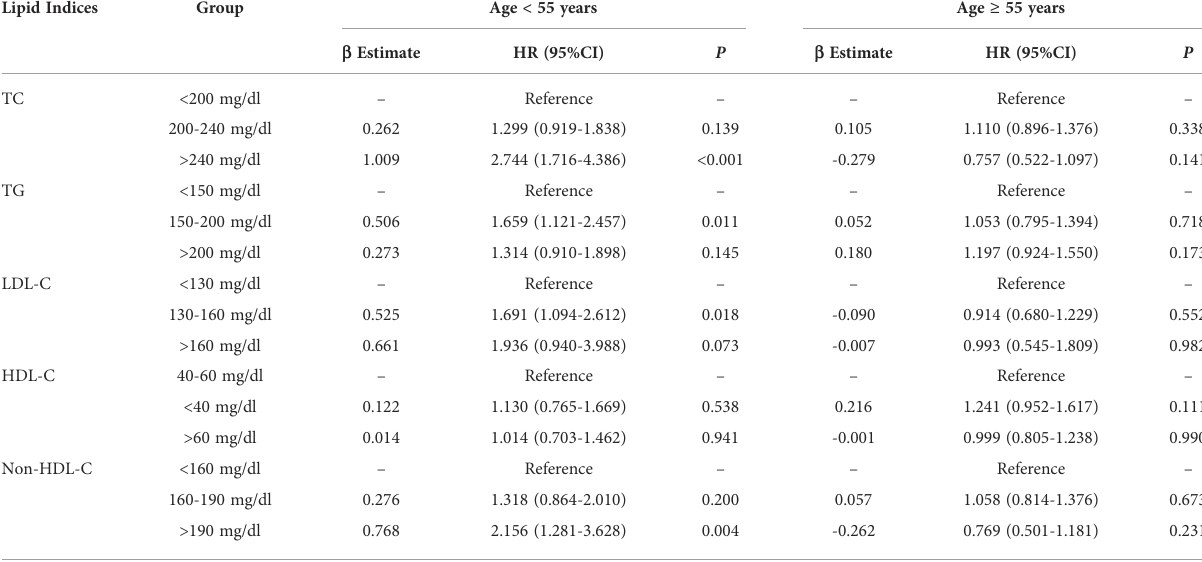
TABLE 3 Multivariable association between lipid indices and the risk of hypertension by age groups. Lipid